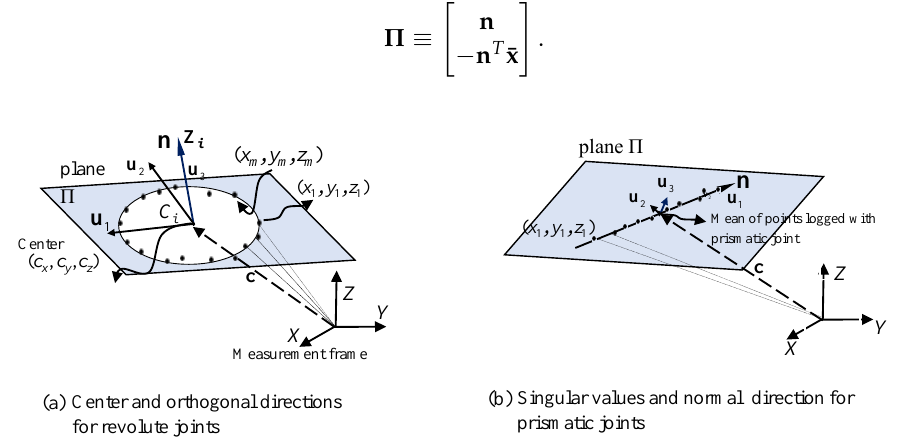
Figure 13. Position data points on the circle and the line obtained with the revolute and prismatic joint actuation respectively with its singular value